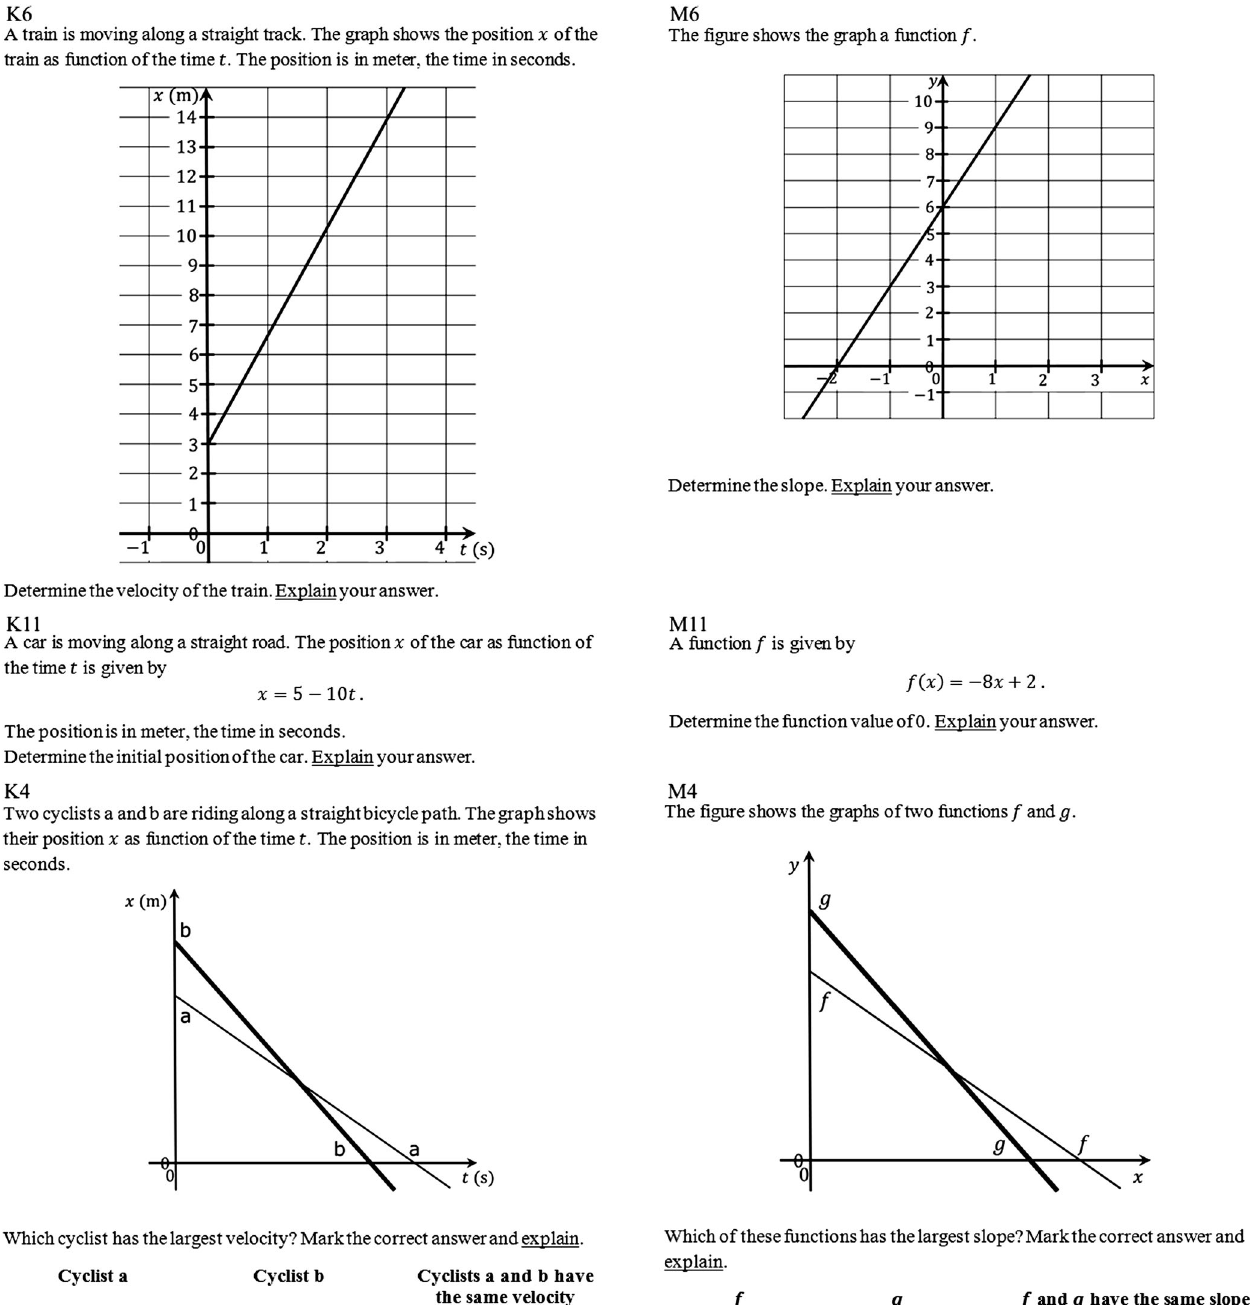
FIG. 2. Three kinematics(K) items andthe three isomorphic mathematics (M)examplesillustrating the differentfactors in thetest